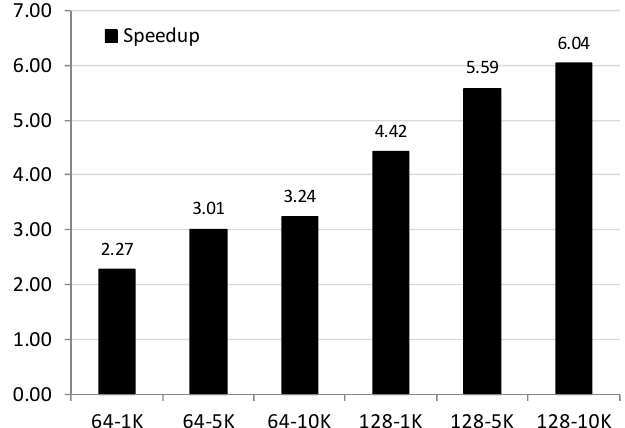
Figure 8. Speedup when comparing CPU and GPU times from Berlin130 with respect to different populations (64 and 128) and iterations (1000, 5000, and 10,000).